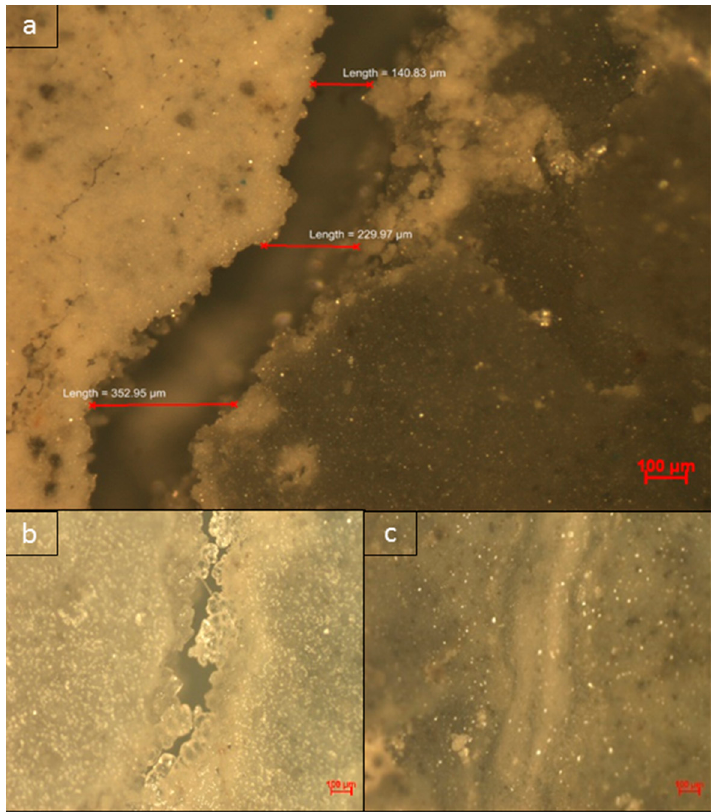
Figure 14. 5× magnification images of cracks; ( a ) initial crack after 7 days of curing; ( b ) partially healed section of a crack; ( c ) completely healed section of a crack in NS1-cement mortar after 28 days.